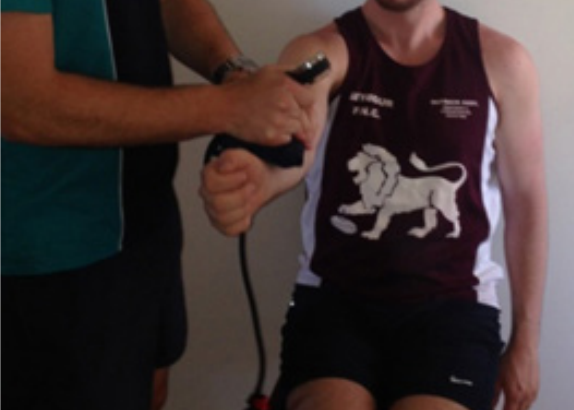
Figure 2 - Measurement procedure for shoulder abduction strength.